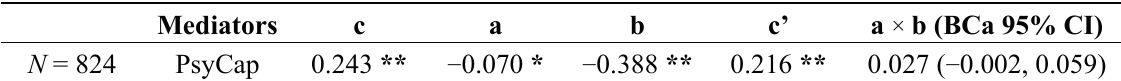
Table 11. WFC as the independent variable and PsyCap as the mediator in the regression